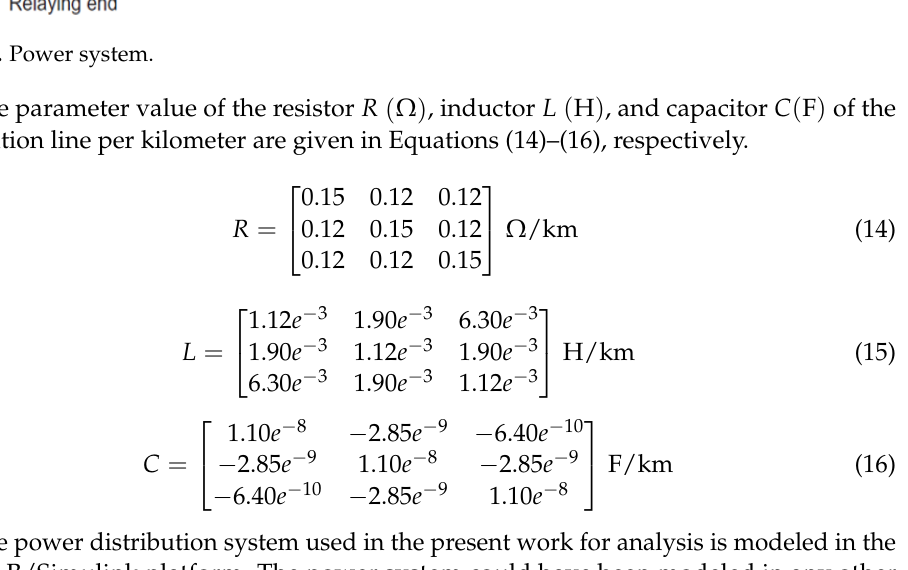
Figure 6. Power system.